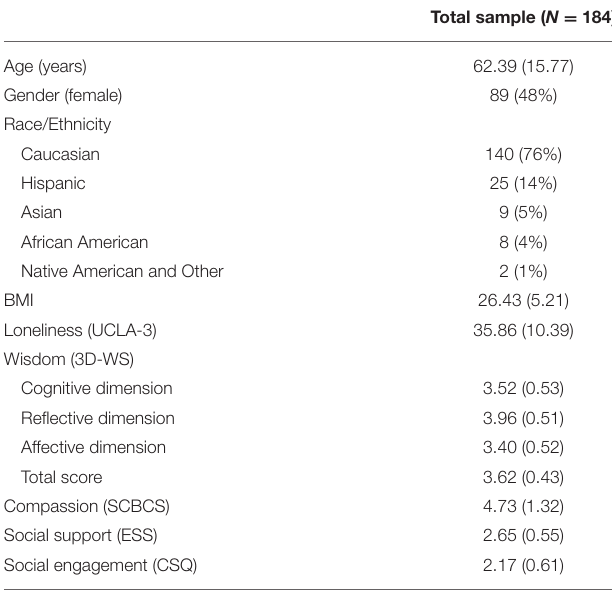
TABLE 1 | Demographic and clinical characteristics of the